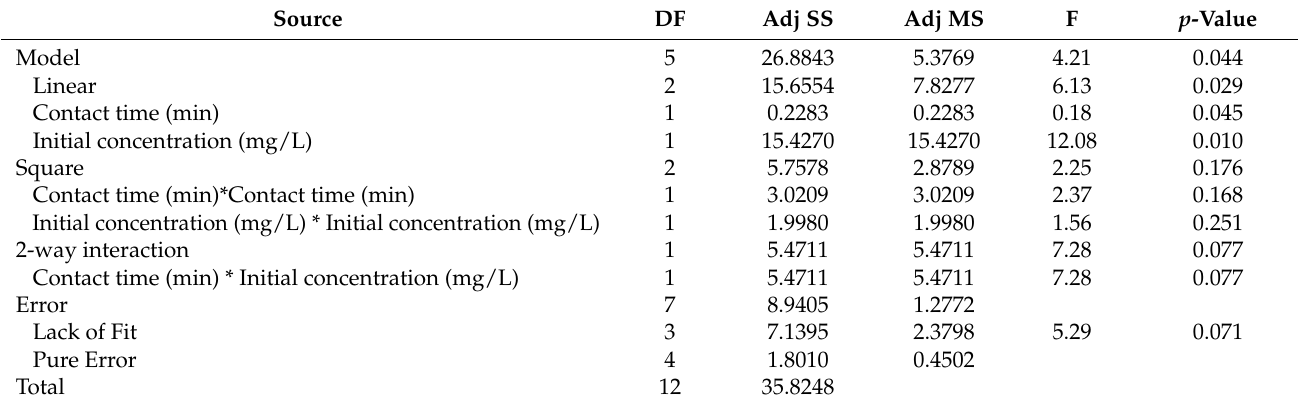
Table 2. ANOVA results in the CCFC